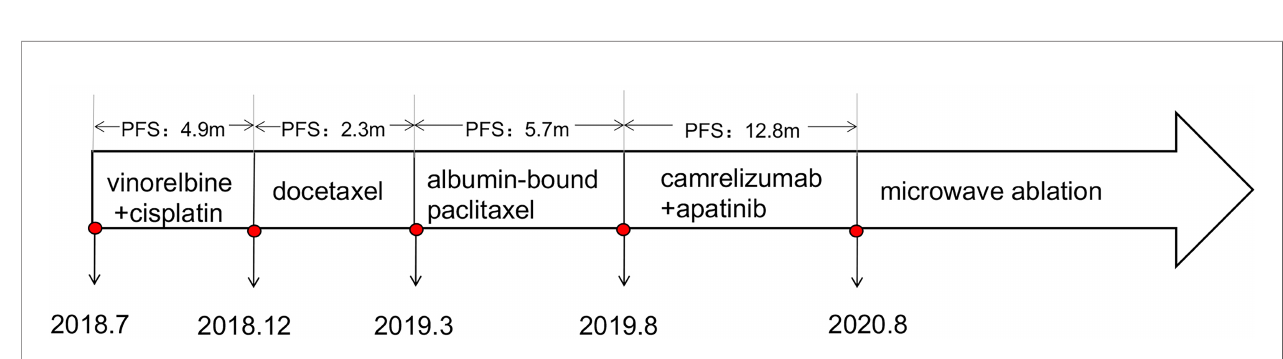
FIGURE 3 | Timeline of treatment administration from the episode of care.